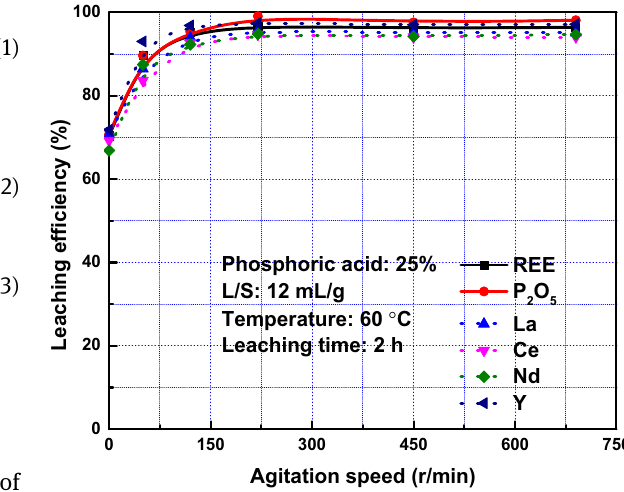
Figure 6: Leaching e ffi ciencies as a function of agitation speed.